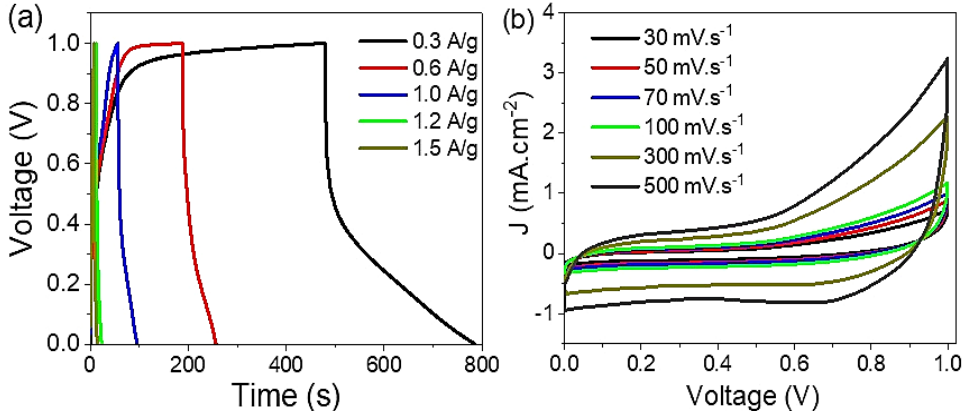
Figure 4. ( a ) Charge/discharge and ( b ) Cyclic voltammetry for symmetric supercapacitor based on NiS-NiO/G-C3N4 nanocomposite under HCl electrolyte.